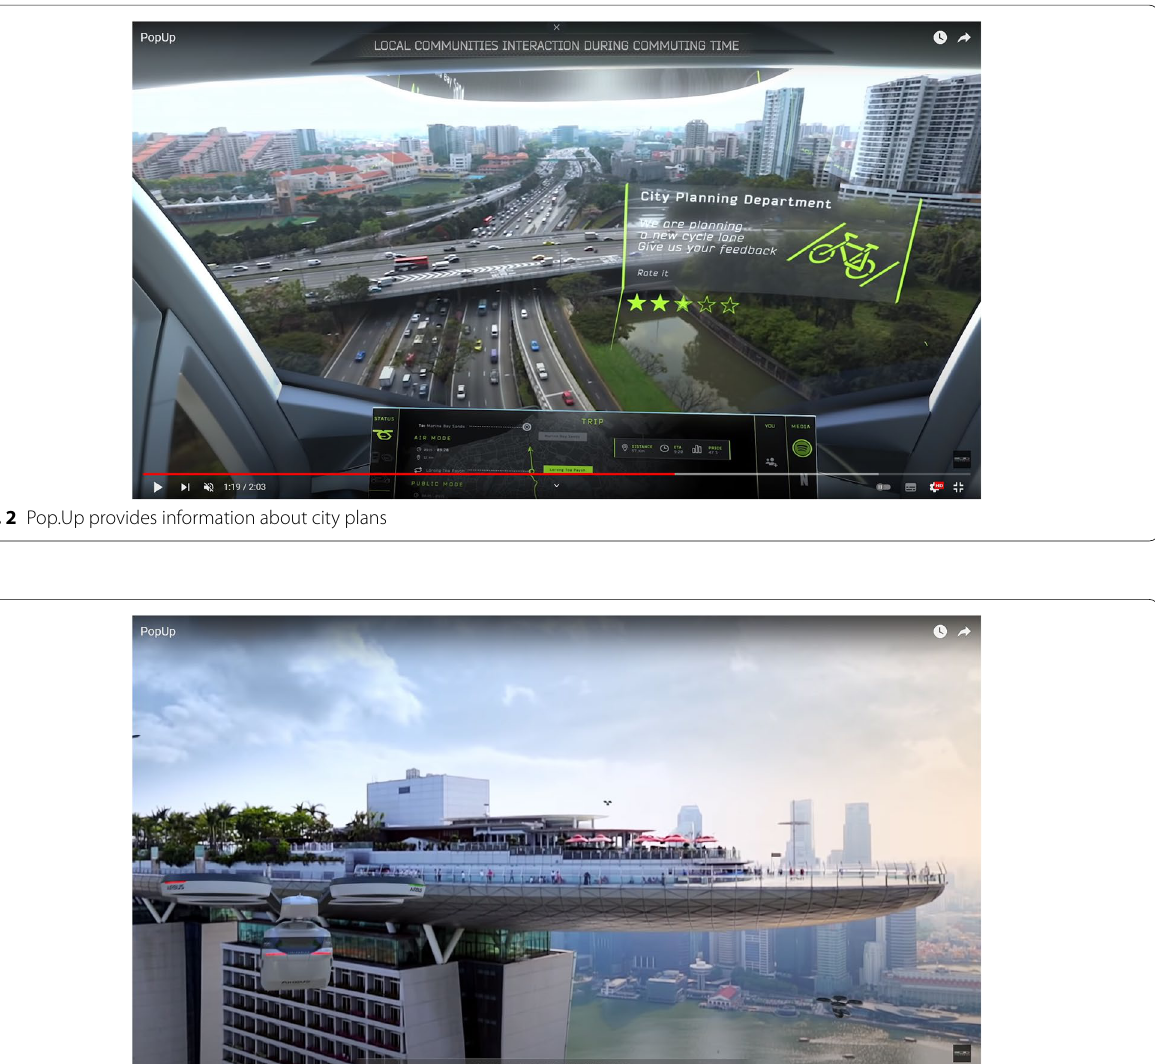
through the explication of congestion as a reference problem, the concept video has a different focus. By depicting the everyday world, identification processes are constituted cinematically. Topics such as professional careers and relationships are dealt with. Here, the Pop.Up not only solves problems of urban infrastructure, but also nent in everyday life. Despite the identification processes set in motion, the concept video breaks with the viewers’